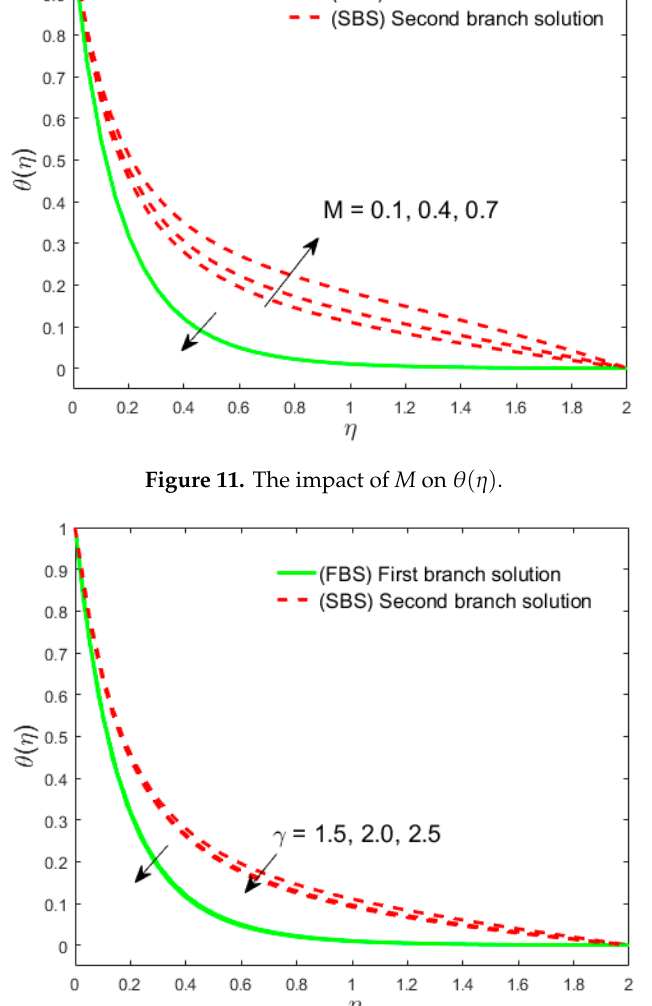
( ) θ η γ . Figure 12. The impact of γ on θ ( η ) on ( ) θ η γ . on